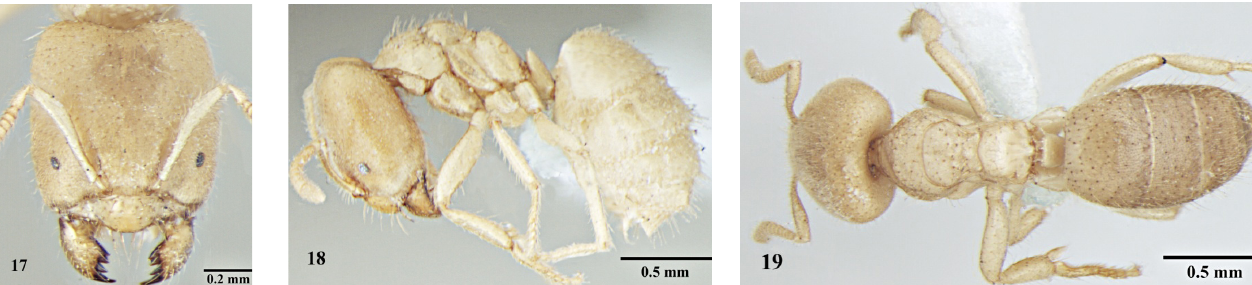
Fig. 17-19 . Pseudolasius polymorphicus sp. n ., major worker 17) head, full face view; 18) body, lateral view; 19) body, dorsal view.